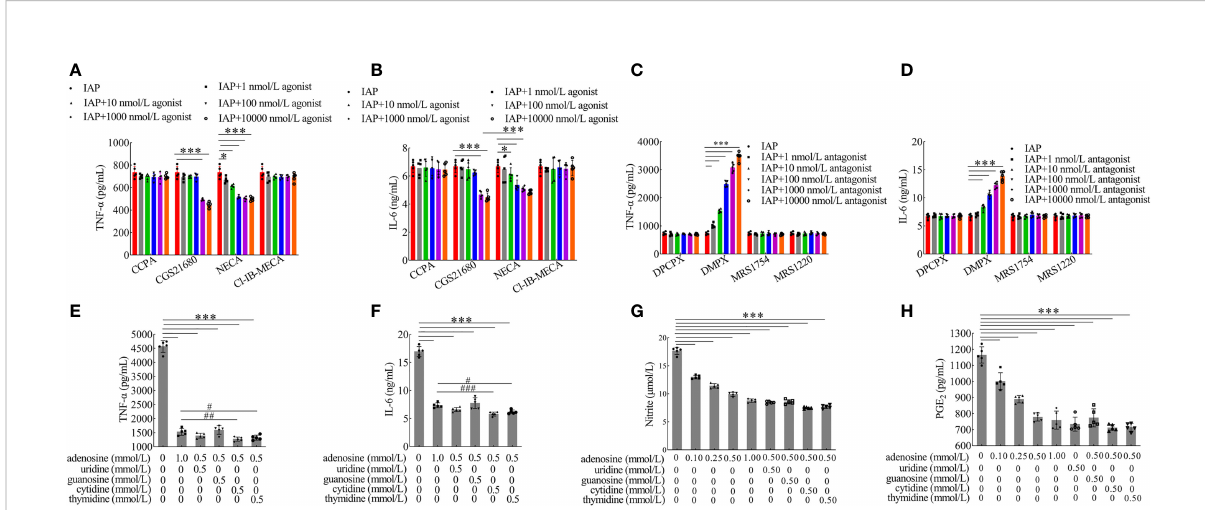
FIGURE 9 Anti-in fl ammatory effect of adenosine receptors and nucleoside synergies. The effect of adenosine receptor (A, B) agonist and (C, D) antagonist on the secretion of TNF- a and IL-6 produced in co-cultured HT-29 cells + freshly extracted human leucocytes. The effect of adenosine and other nucleosides on (E) TNF- a , (F) IL-6, (G) NO, and (H) PGE 2 in cocultured HT-29 cells + freshly extracted human leucocytes. Values are presented as means ± SD (n = 5 wells/group). Analysis of variance with Tukey. (A – D) *P < 0.05; ***P < 0.001. (E – H) compared with the control, ***P < 0.001; compared with the adenosine group (1 mmol/l), # P < 0.05, ## P < 0.01, ### P < 0.001. CCPA: A 1 receptor agonist, CGS21680: A 2A receptor agonist, NECA: A 2A and A 2B receptor agonist, CI-IB-MECA: A 3 receptor agonist, DPCPX: A 1 receptor antagonist, DMPX: A 2A receptor antagonist, MRS1754: A 2B receptor antagonist, MRS1220: A 3 receptor antagonist.